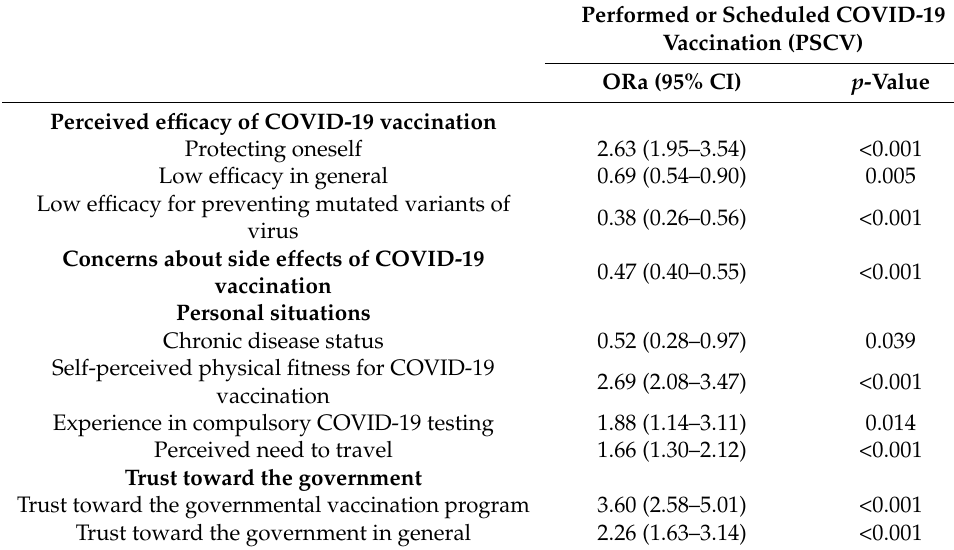
Table 4. Adjusted associations between potential factors and performed or scheduled COVID-19 vaccination (n =